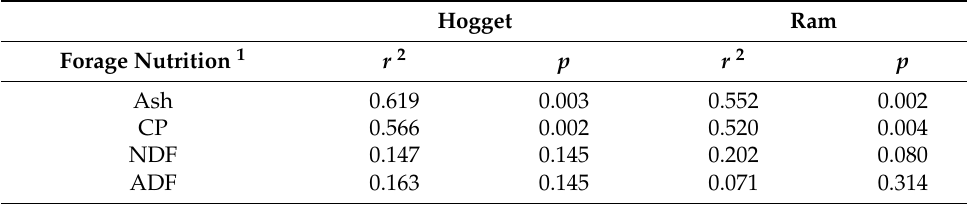
Table 3. Mantel test revealed the correlation between forage nutrition and rumen bacteria (OTU level) of hoggets (H) and rams (R) of grazing Alpine Merino